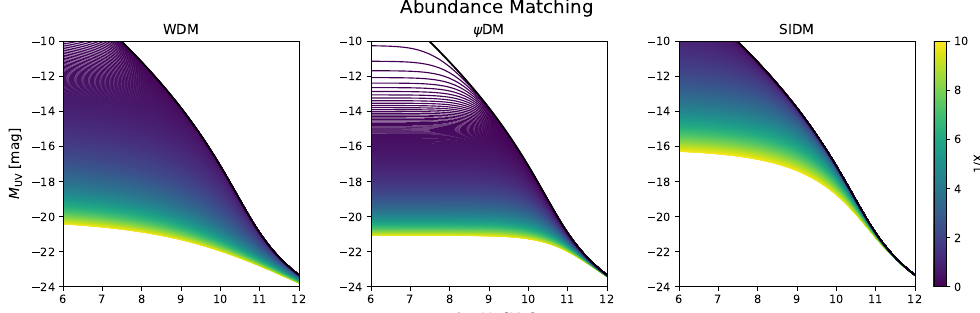
Figure 3. Relationship between the UV magnitude M UV and the halo mass M H at a reference redshift z ≈ 10, derived from the abundance matching of the observed UV luminosity function and the halo mass function (see text for details) in different DM scenarios: WDM (left panel), ψ DM (middle panel) and SIDM (right panel). The colorbar refers to values of keV/ m X for WDM, 10 − 22 eV/ m X for ψ DM and keV/ T X for SIDM. In all panels, the black line refers to the standard CDM